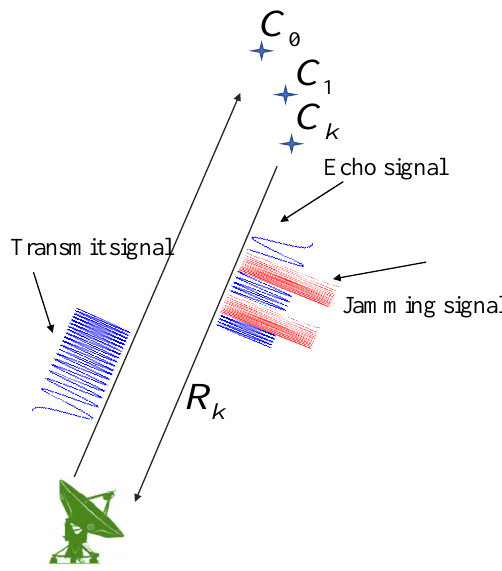
Figure 1. The working scenario of a high-resolution